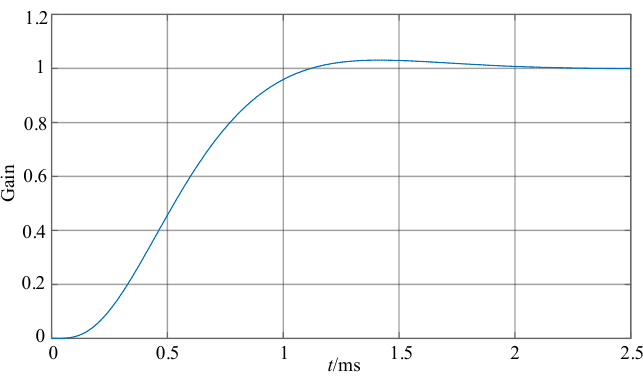
Figure 16. Step response plot of speed closed loop.